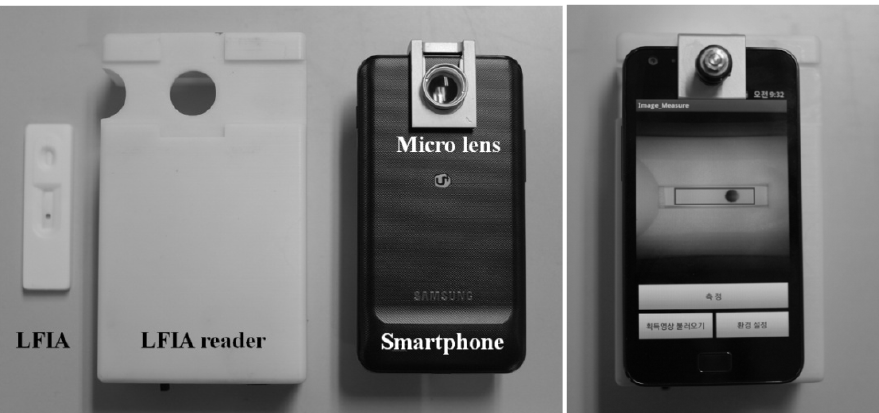
Figure 2. Smartphone-based reading